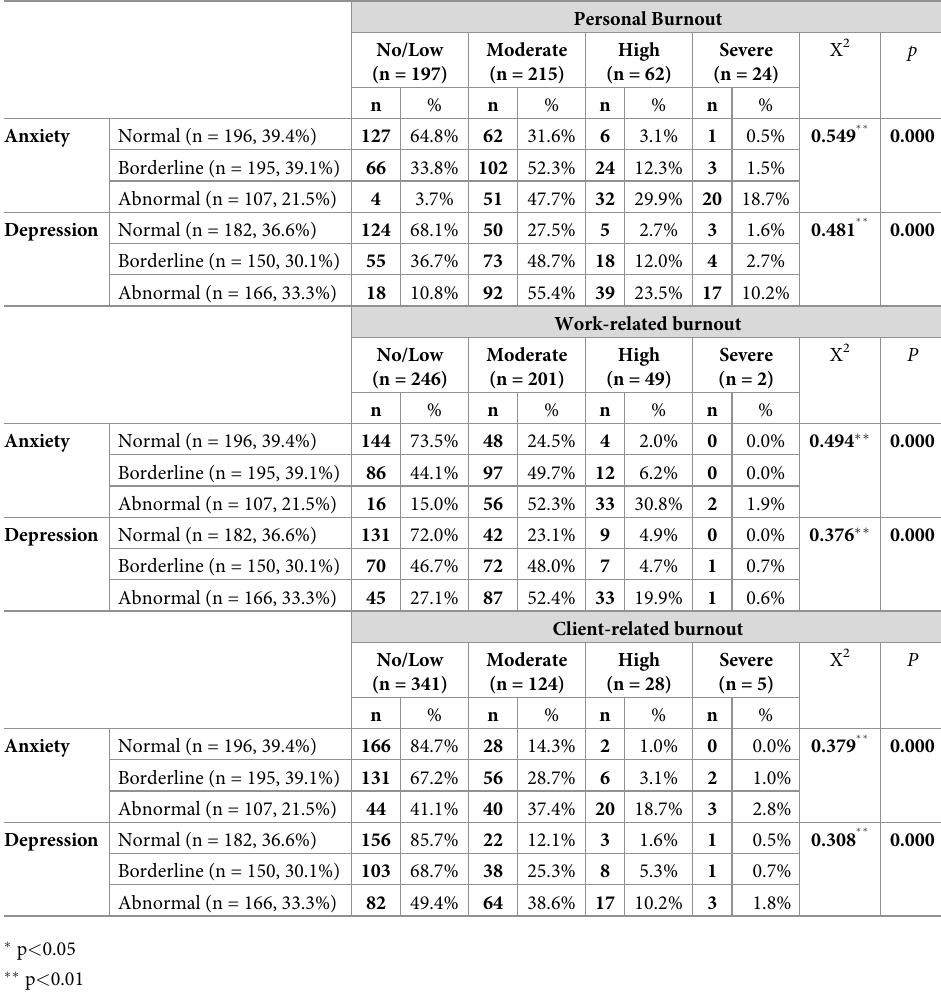
Table 4. Prevalence of burnout, depression and anxiety among the participants (n =